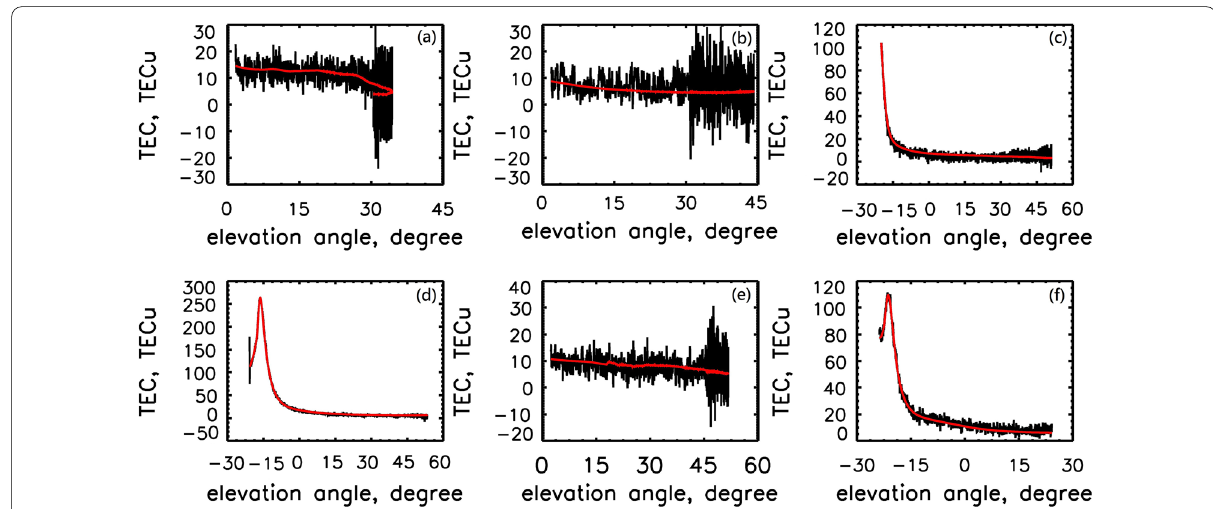
Fig. 8 Six examples of absolute TEC profiles of the F7/C2 TGRS retrieved from TROPS. The black and red curves show the TEC retrieved from pseudorange and phase, respectively. The information is recorded in a podTc2_F701.2020.099.00.55.R18_0001.0001_nc; b